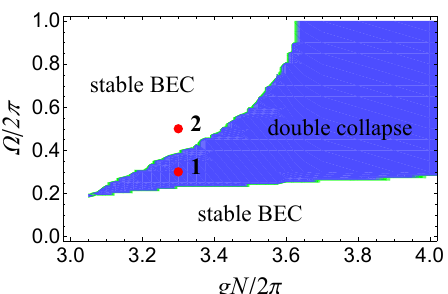
Figure 4. The diagram of the stable and collapsing BEC is presented in ( gN , Ω ) -plane for cross-spin interaction with κ = 1 in Equation (1). The plot corresponds to initial width a 0 = 1. For the values of ( gN , Ω ) from fixed points (1,2) characteristic condensate dynamics will be presented below in the next